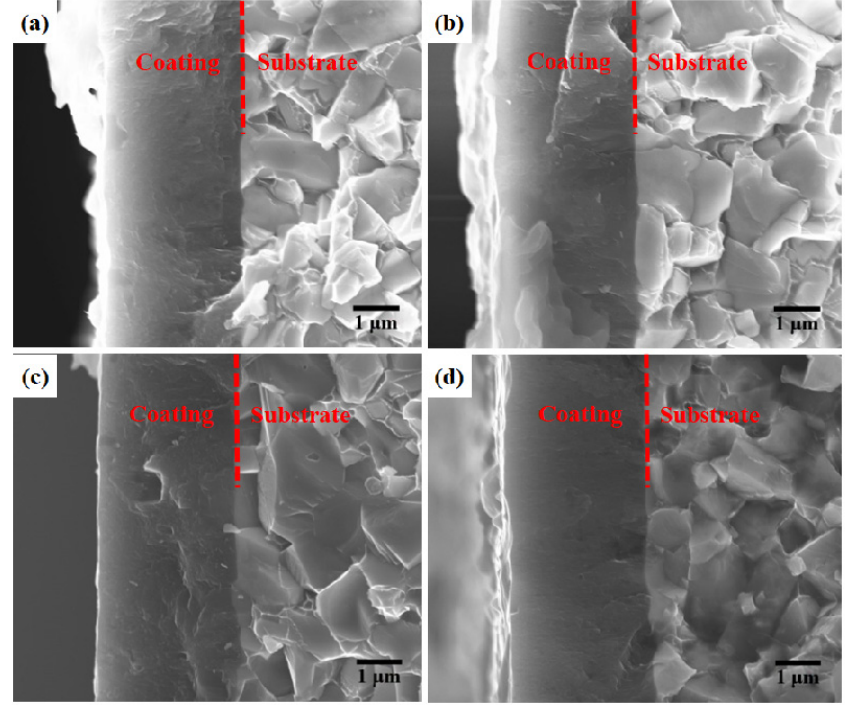
Figure 2. XRD patterns of (a) TiAlN/WT1, (b) TiAlN/WT2, (c) TiAlN/WT3 and (d) TiAlN/WT4 coated cemented carbides.